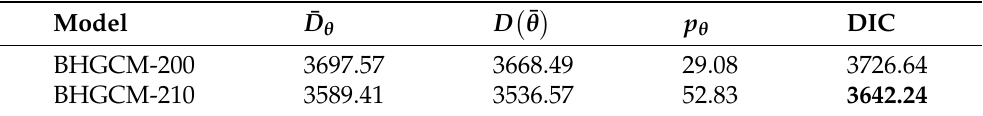
Table 1. Results of using the DIC for the copula models. Boldface indicates the better model.